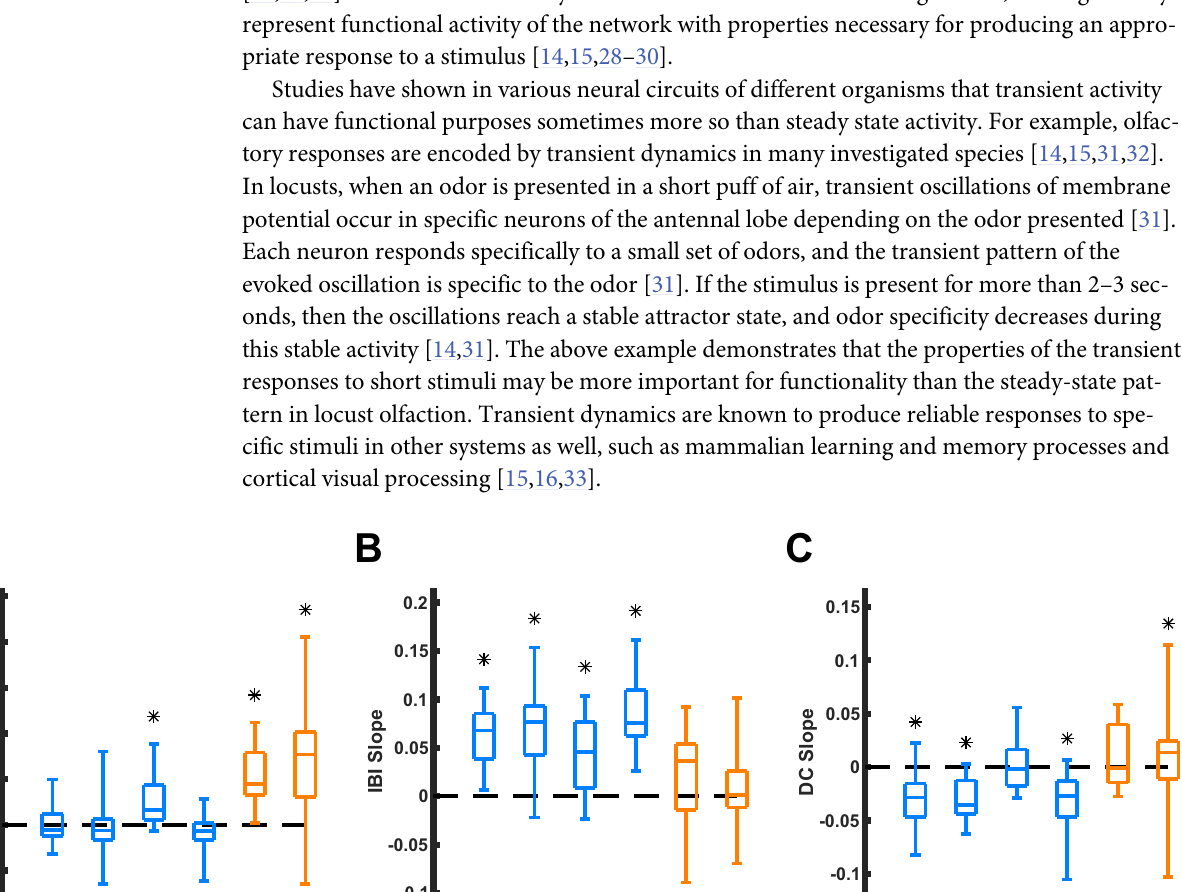
Fig 10. EMG burst duration (BD), interburst interval (IBI), duty cycle (DC), and cycle period (CP) of hindlimb extensor and flexor activity as functions of time during paw-shake response. Gray straight lines represent linear regression lines. Slope values shown in each panel represent the mean ± SD of the regression slope coefficient. EMG characteristics of extensor muscles ( gastrocnemius medial , MG; soleus , SO; vastus lateralis , VA; and biceps femoris anterior , BFA) are indicated by blue lines; characteristics of flexor muscles ( iliopsoas , IP and tibialis anterior , TA) are in orange. Data are from all 12 cats and 113 paw-shake episodes (Table 3).